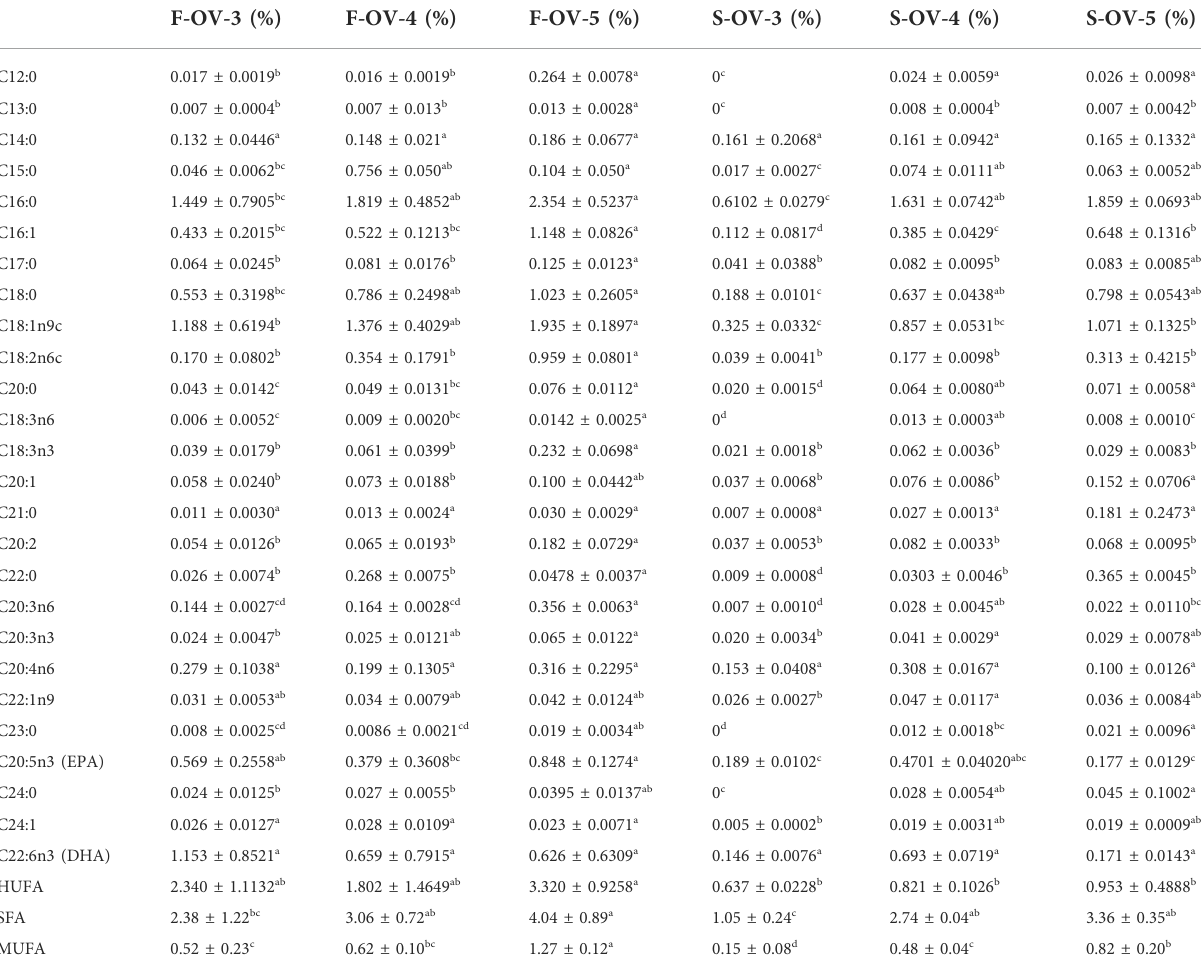
TABLE 8 Pro fi le of fatty acids in female Scylla paramamosain ovary during the two vitellogenesis